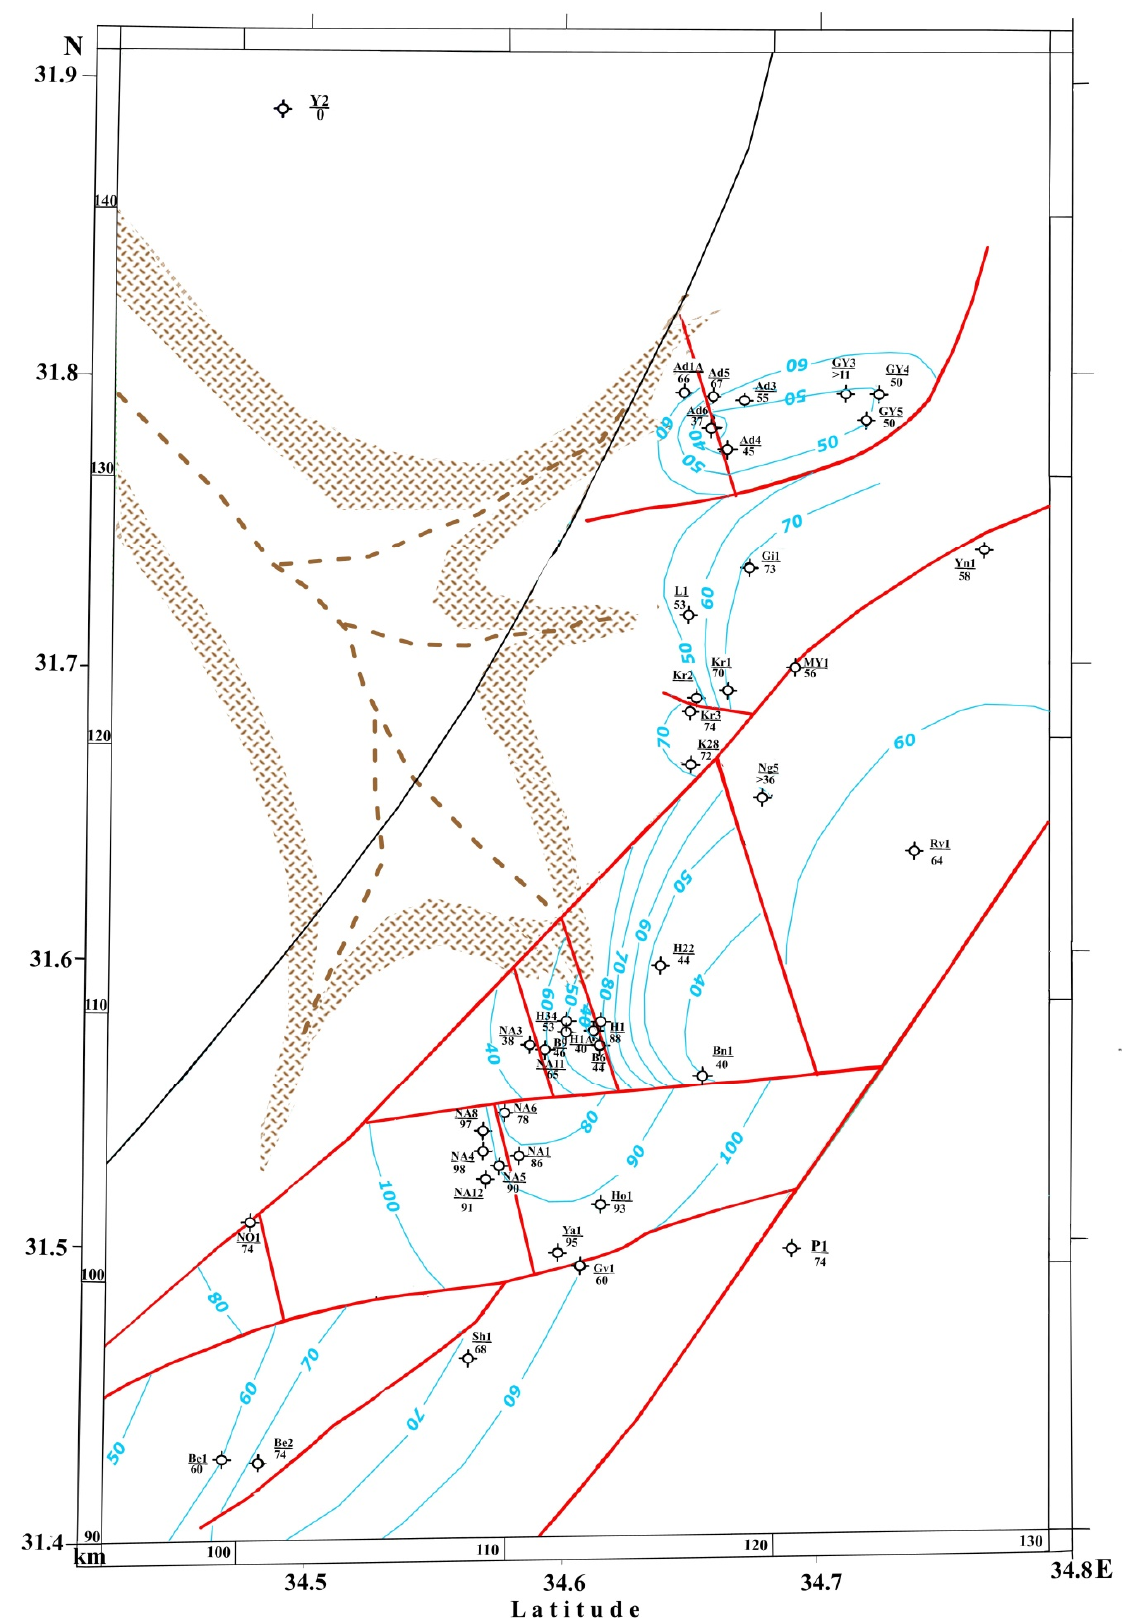
Figure 12. A map of the thicknesses of the Upper Bathonian (Karmon Formation) of the Heletz– Ashdod oil field. The brown color shows the erosional canyon, and blue lines are the isopachs. Borehole abbreviations: see captions for Figure 2.